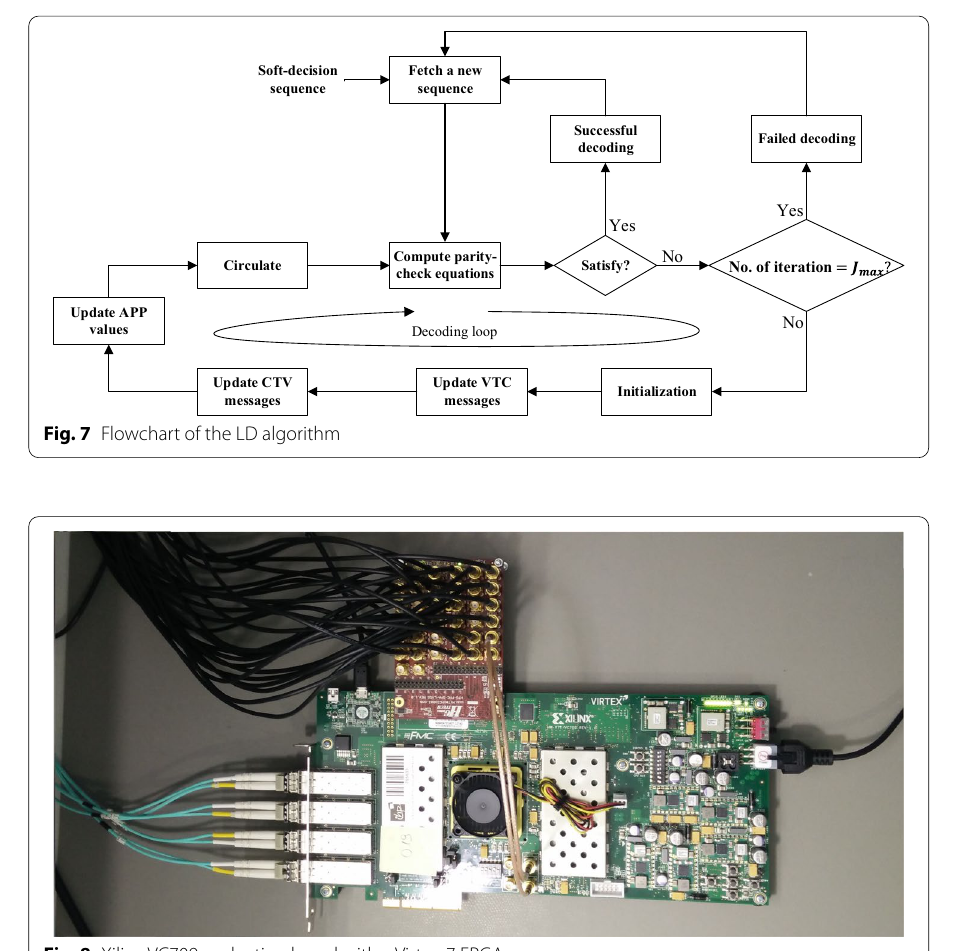
Fig. 8 Xilinx VC709 evaluation board with a Virtex-7